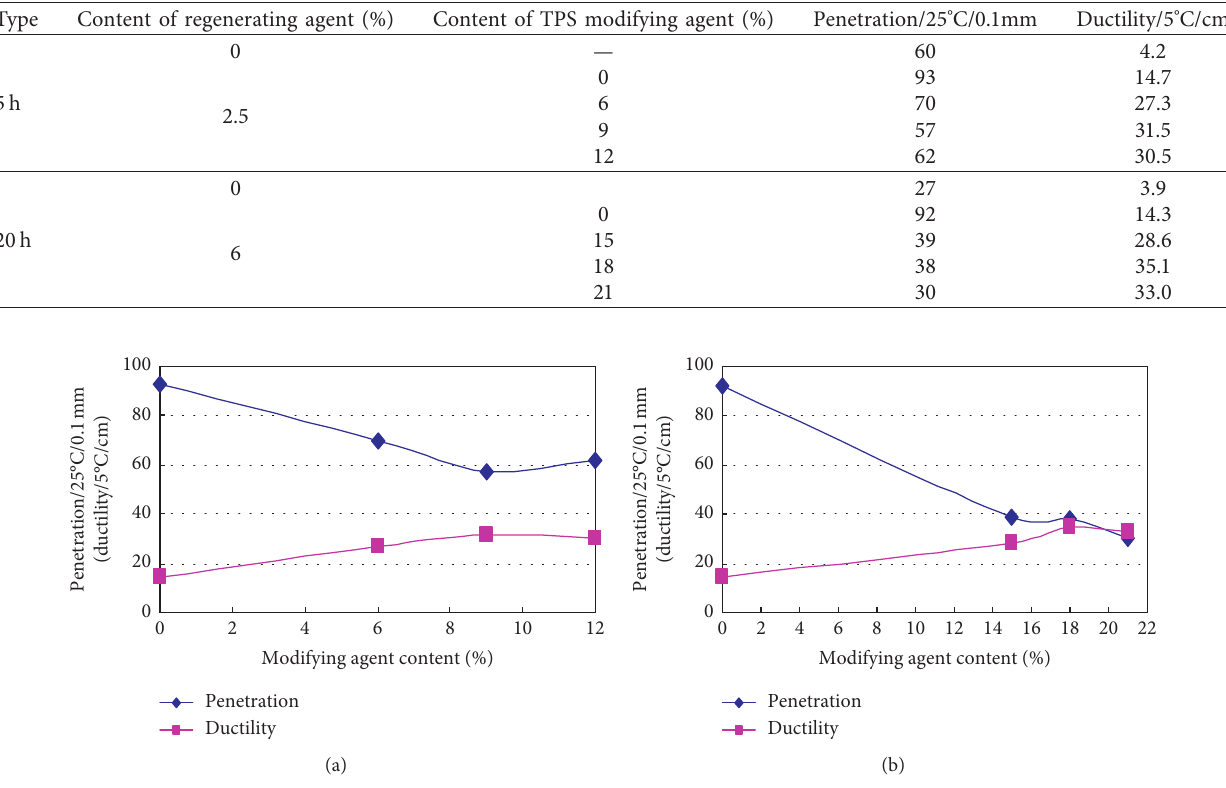
Table 7: Indexes of modified regenerating asphalt in different modifying agent contents.